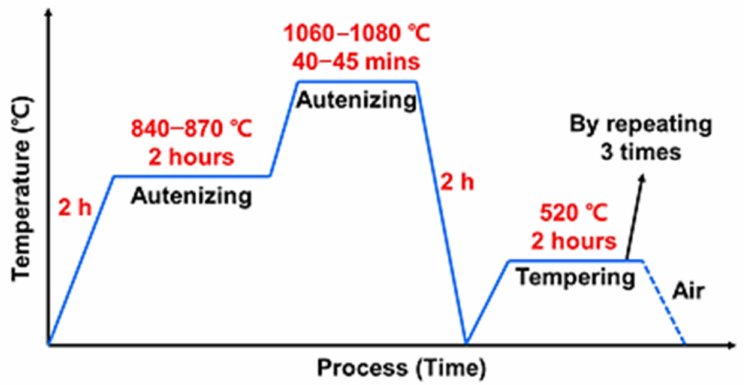
Figure 2. Schematic representation of the heat-treatment